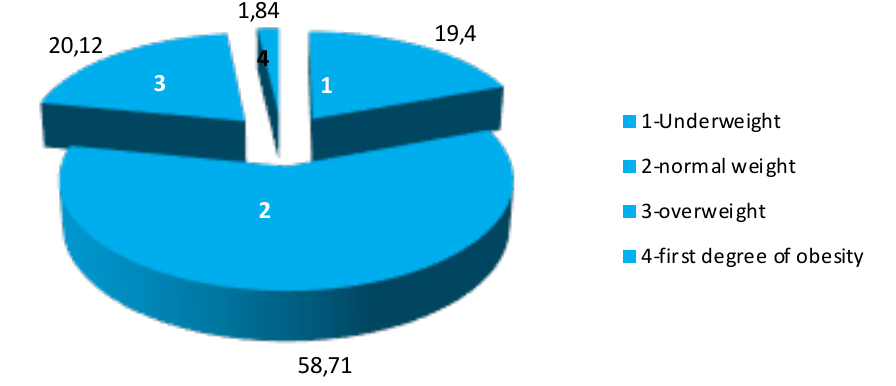
Fig. 2. Distribution of males according to BMI (in % to quantity of examined